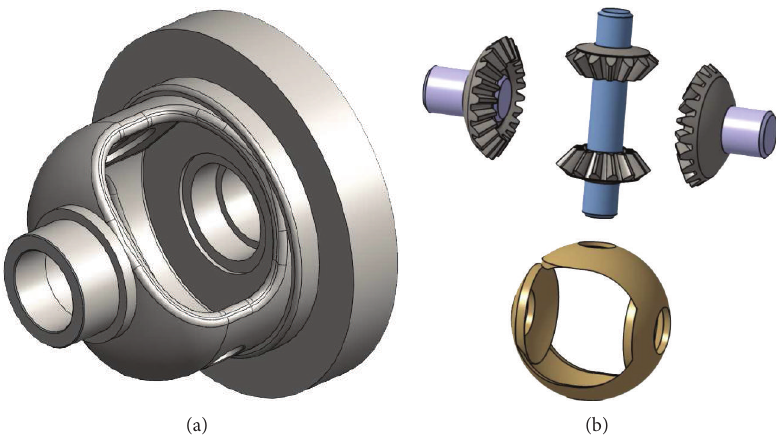
Figure 2: (a) Sump of a differential gearbox. (b) Various components of a differential mechanism.